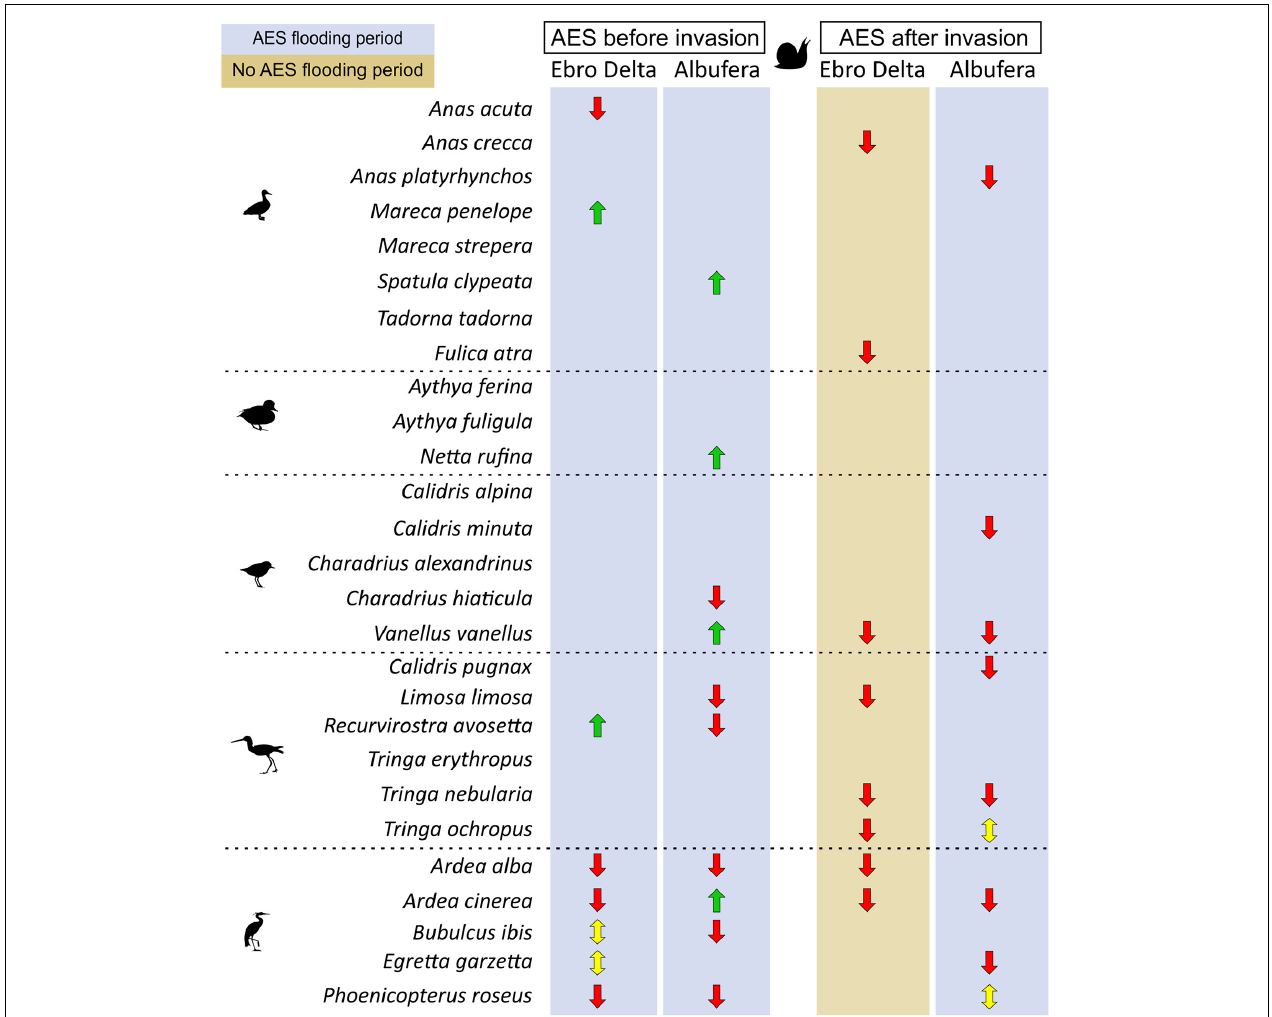
FIGURE 2 | Trend changes of waterbird abundance in the Ebro Delta and l’Albufera in two periods defined by the invasion of the apple snail in the Ebro Delta (left block: AES before invasion; right block: AES after invasion). The two blue rectangles in the block “AES before invasion” indicate that rice fields were flooded in winter in the Ebro Delta and l’Albufera due to the AES. While the brown and blue rectangles in the block “AES after invasion” indicate that rice fields were flooded in winter in l’Albufera, but not in the Ebro Delta due to apple snail control. Information on the block AES before invasion aims to test our hypothesis on the positive effect of winter flooding on trend in waterbird abundance, while information on the block AES after invasion aims to test our hypothesis on the negative side effect of stopping winter flooding (see hypothesis in main text). The green and red arrows indicate the occurrence of a, respectively, statistically significant increase or decrease in the abundance trend in that period. The yellow arrows indicate that there were multiple and antagonistic trend changes, or those changes were too complex to draw any conclusion. This figure does not inform on existing trend changes before the onset of the AES winter flooding. For full details on all trend changes, their timing, and the abundance trends before and after trend changes (see Supplementary Figures 1–4 and Supplementary Tables 1, 2